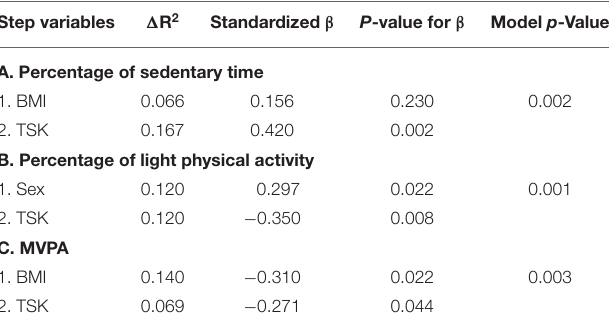
TABLE 5 | Summary of hierarchical regression analyses for physical activity variables with TSK as final